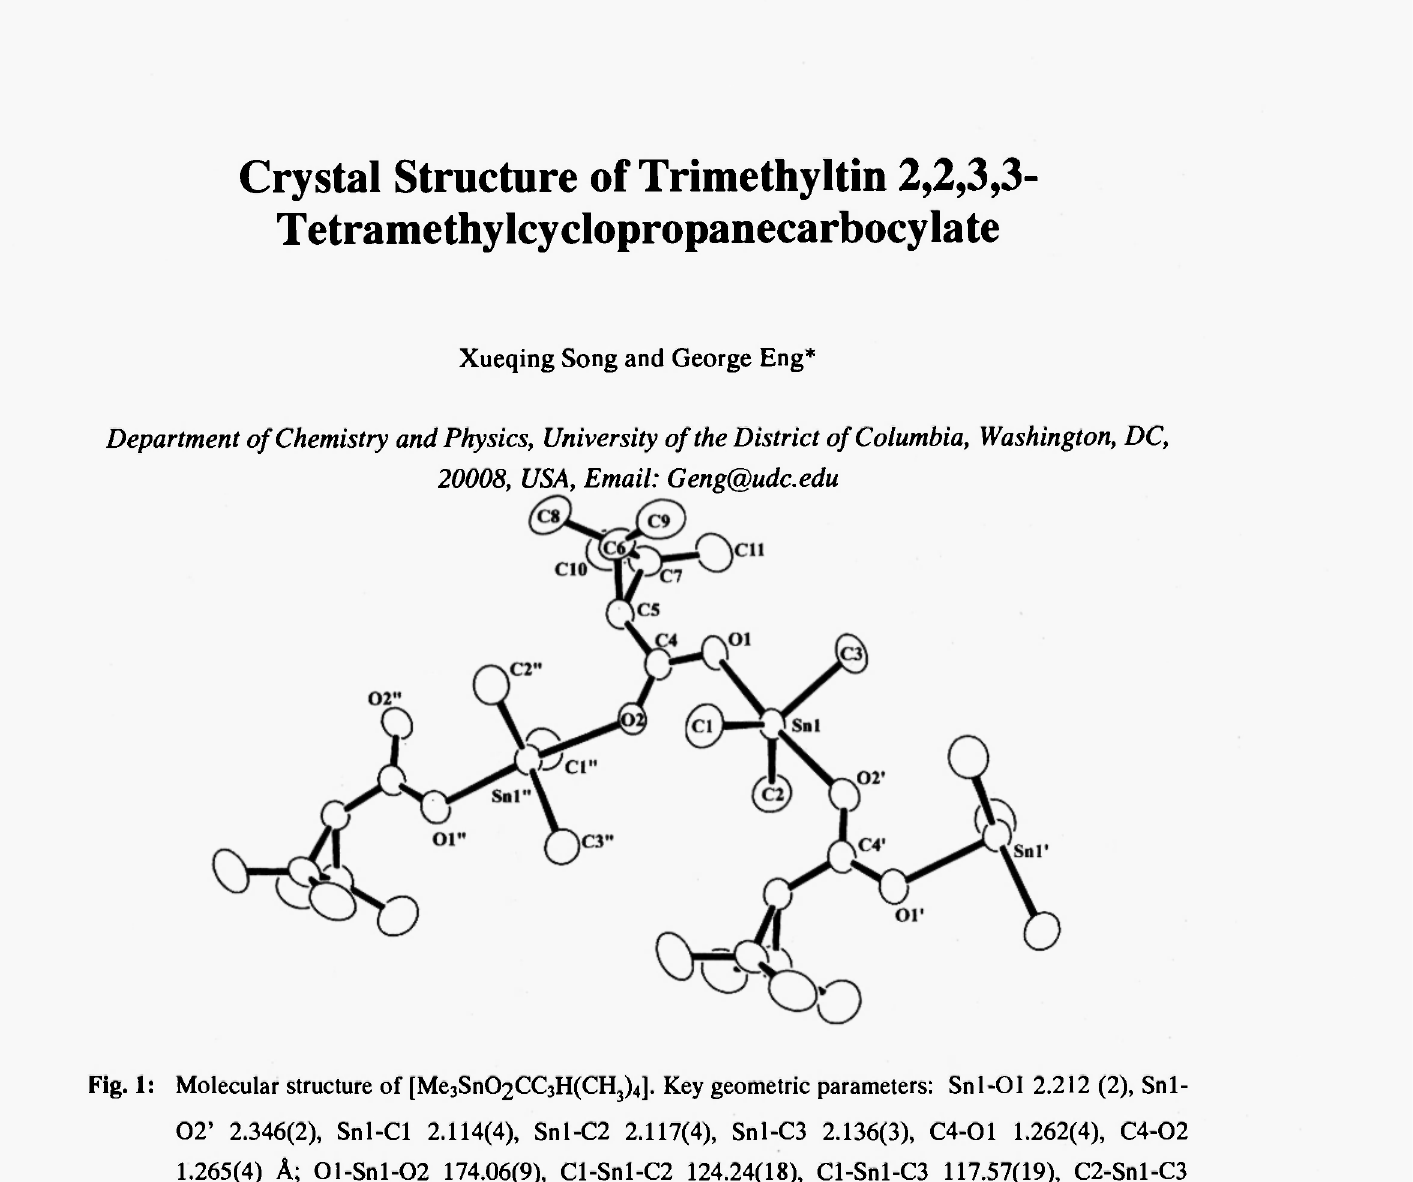
Fig. 1: Molecular structure of [Me Sn02CC3H(CH ) ]. Key geometric parameters: Snl-OI 2.212 (2), Snl- 3 3 4 02' 2.346(2), Snl-Cl 2.114(4), Snl-C2 2.117(4), Snl-C3 2.136(3), C4-01 1.262(4), C4-02 1.265(4) A; 01-Snl-02 174.06(9), Cl-Snl-C2 124.24(18), Cl-Snl-C3 117.57(19), C2-Snl-C3 117.75(19), 01-Snl-Cl 93.75(14), 01-Snl-C7 94.44(14), 01-Snl-C13 88.15(13)°, Η-atoms omitted for clarity. Symmetry code: (i) 1-x, y-0.5,0.5-z; (ii) 1-x, 0.5+y,